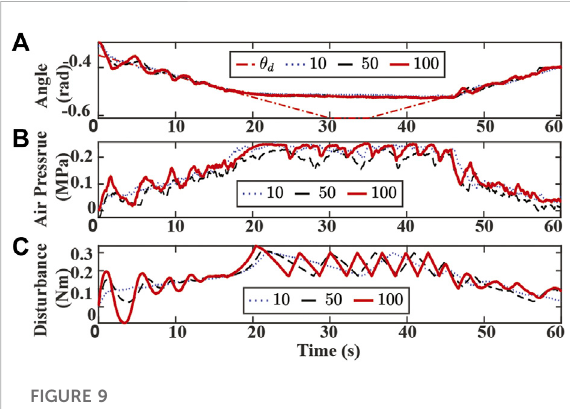
FIGURE 9 Experiment results of tracking bending angle with obstacle and changing k sf . (A) Bending angle tracking results where θ is the original desired (dash-dotted red), and k sf are set to 10 (dotted blue), 50 (dashed black), 100 (solid red), respectively. (B) Air pressure measurements of chamber 1. (C) Lumped disturbance estimation.